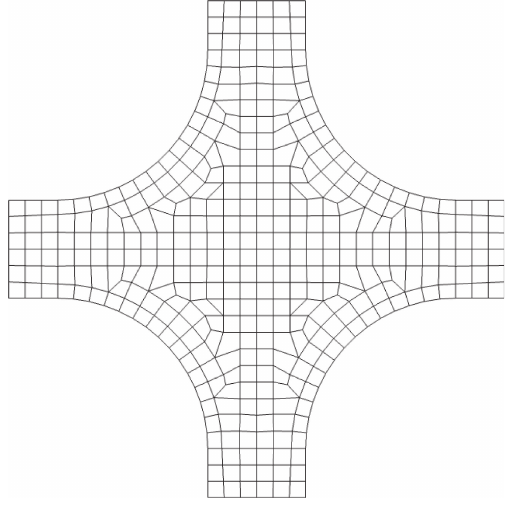
Figure 1: Cross-section view of grid level 1. Table 3: Characteristics of the grids used in the